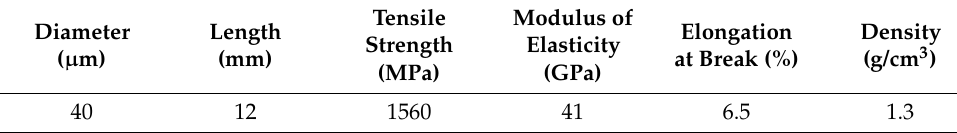
Table 4. PVA fiber performance